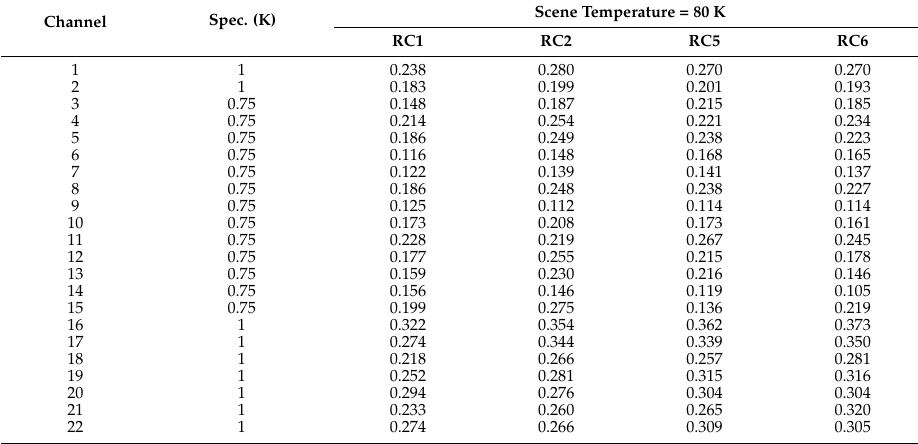
Table 3. SNPP ATMS Prototype Flight Model (PFM) in-orbit calibration accuracy at cold scene for four redundant configurations (RC1, RC2, RC5, RC6).